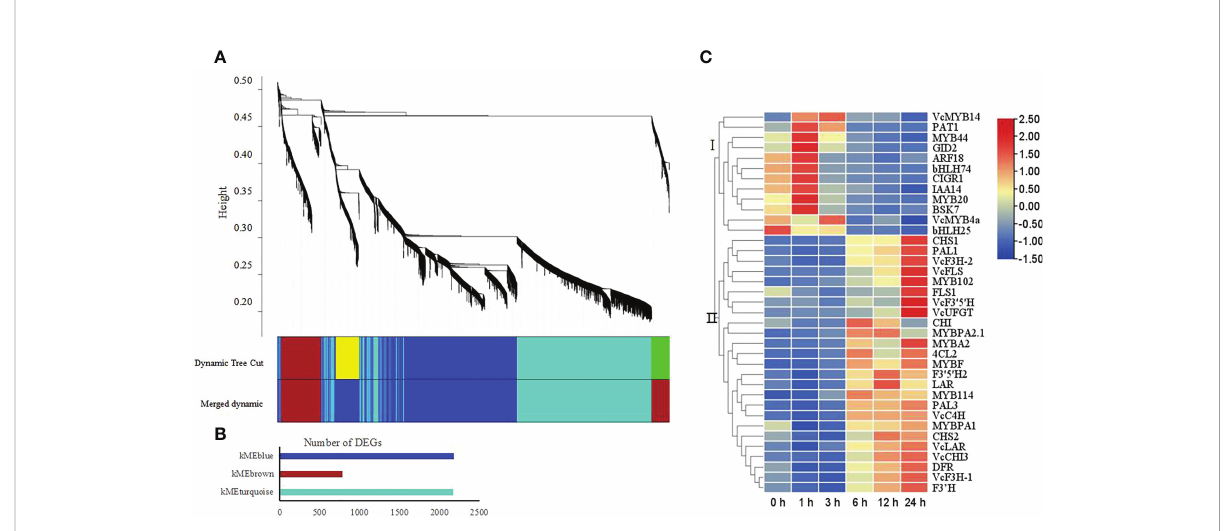
FIGURE 5 Weighted gene co-expression network analysis (WGCNA) of DEGs obtained from all pairwise comparisons. (A) Hierarchical clustering tree showing the co-expression modules identi fi ed by WGCNA. Different modules are marked with different colors. Each leaf of the cluster tree represents a gene. (B) Number of assigned DEGs to the different modules. (C) Heatmap representation of hierarchical clustering analysis of identi fi ed genes involved in the phenylpropanoid, fl avonoid, and anthocyanin metabolic pathways, in the plant hormone signal transduction pathway, and encoding transcription factors in the kMEblue module. Blue, low expression; red, high expression, based on log 2